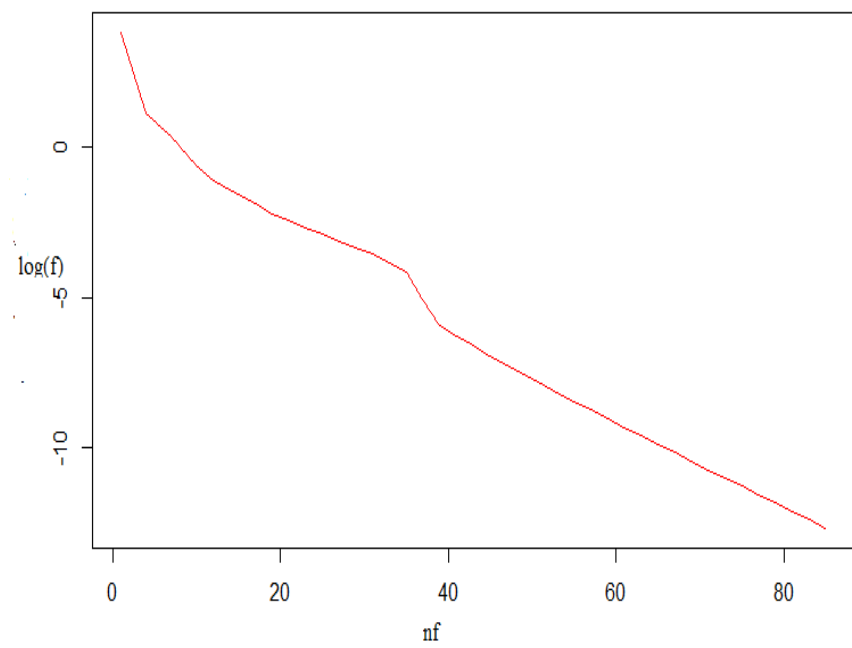
Figure 2. Number of function evaluations due to Classical Gradient Descent algorithm for Example 3.